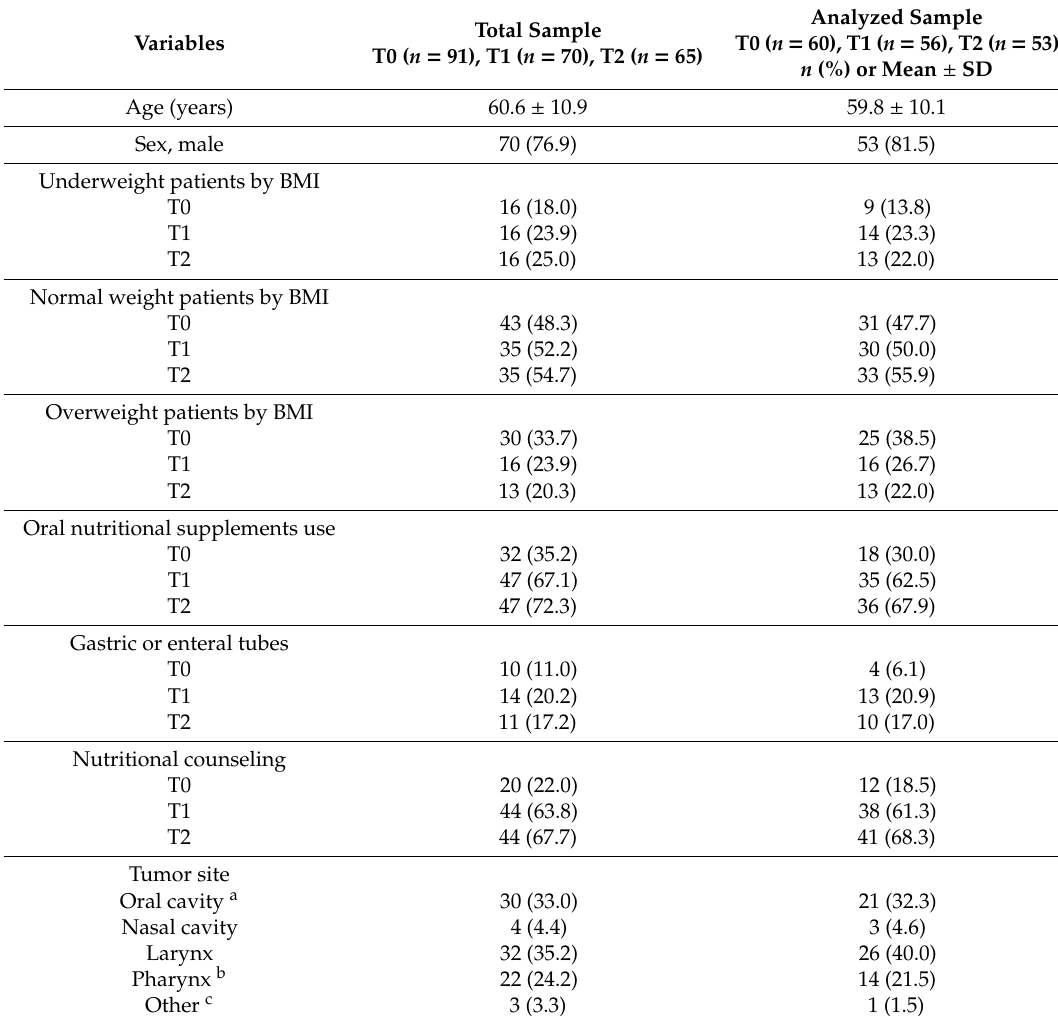
Table 1. Clinical characteristics of